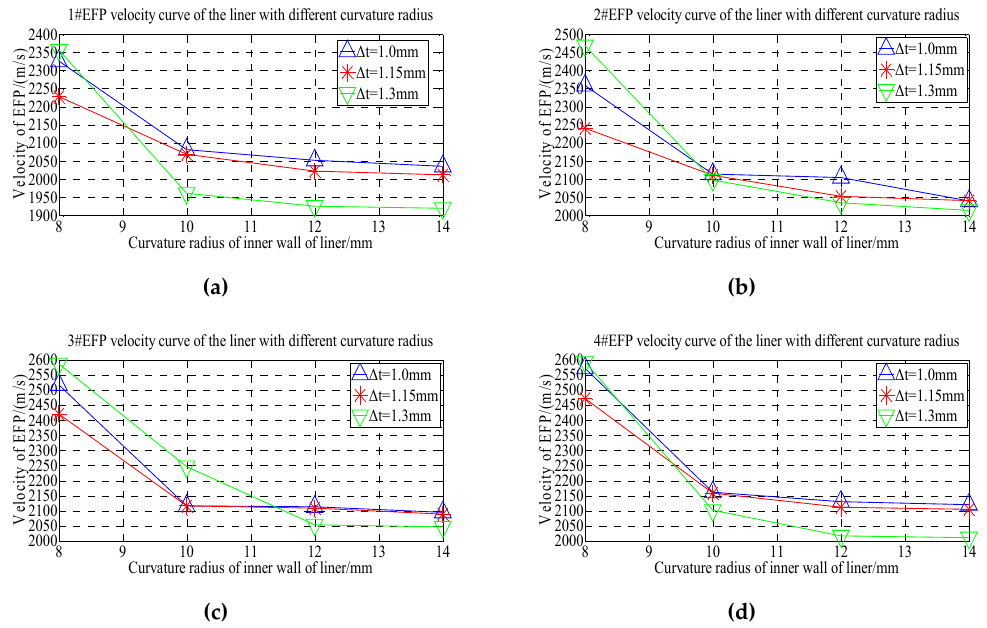
Figure 6. 1#EFP-4#EFP velocity curve of the center of the liner with different thickness: ( a ) 1#EFP velocity curve; ( b ) 2#EFP velocity curve; ( c ) 3#EFP velocity curve;( d ) 4#EFP velocity curve.